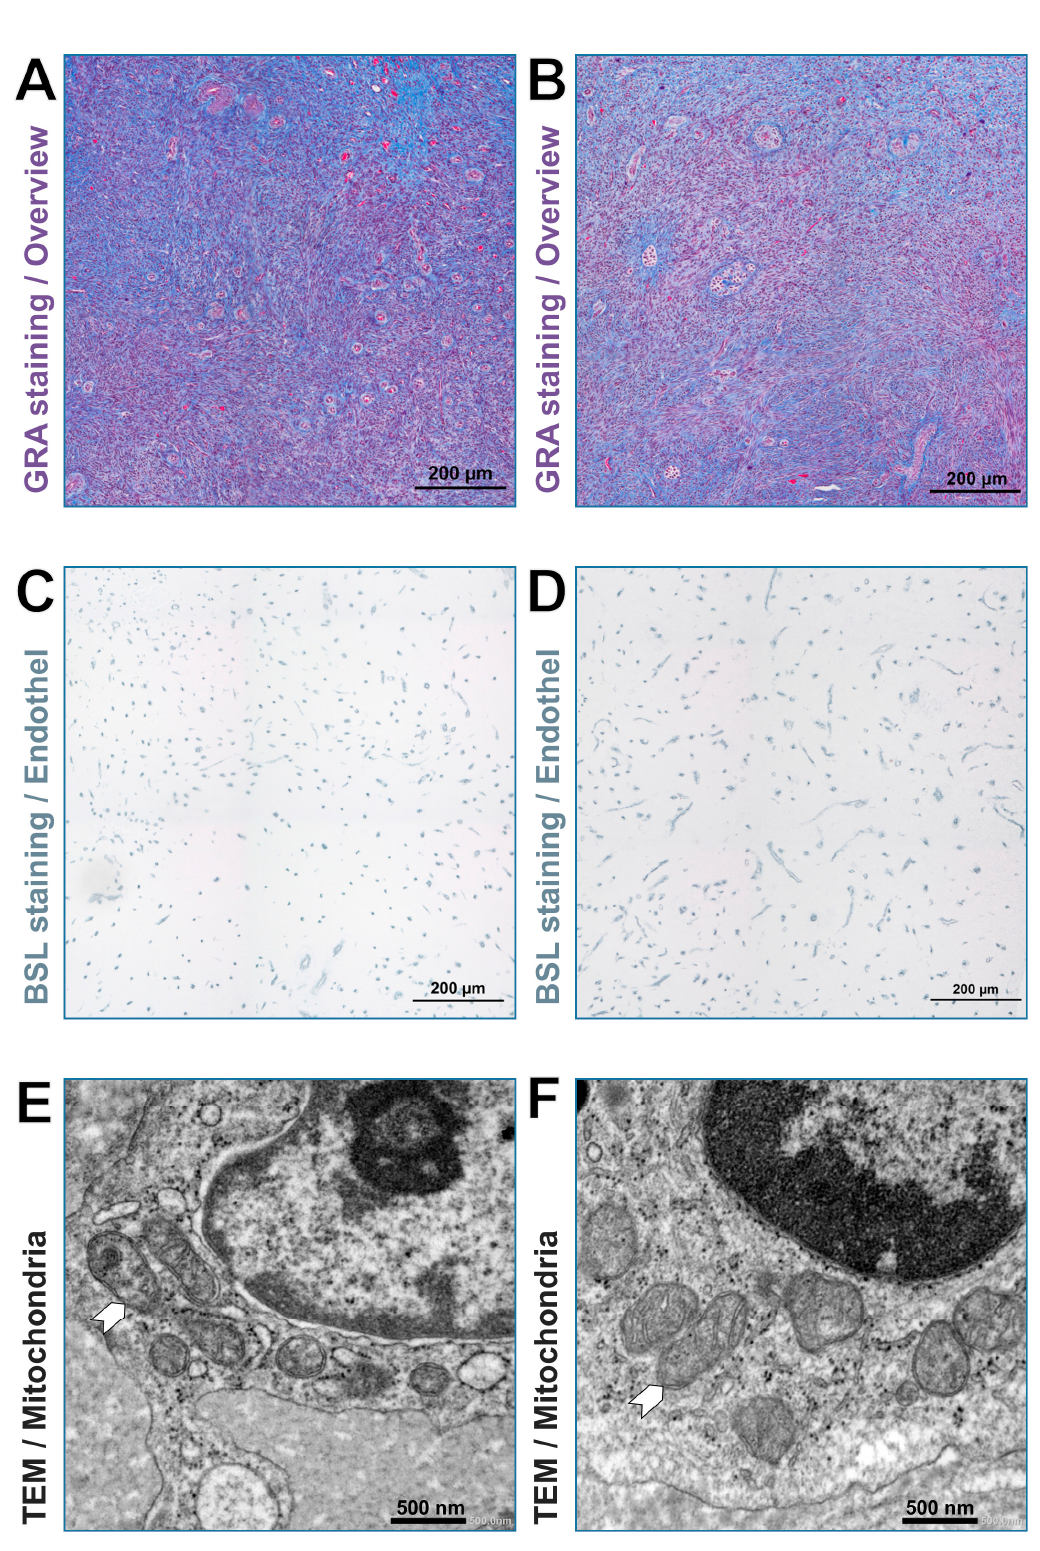
Figure 1. Examples of the measured areas in the ovarian zona parenchymatosa without visible functional structures. ( A , C , E ) Holstein-Friesian. ( B , D , F ) Polish Red cow. ( A , B ) GRA staining. ( C , D ) BSL staining-endothelial cells marked in dark brown-black. ( E , F ), transmission electron microscopic picture showing mitochondria (white arrow heads). Abbreviations : BSL: Bandeiraea simplicifolia agglutinin I; GRA: gallocyanin-, chromotrope 2R- and aniline blue stain; TEM: transmission electron microscopy.